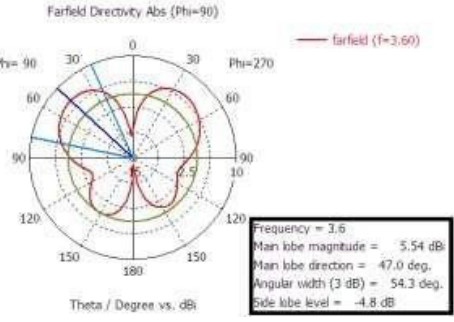
Figure 4.2: Farfield radiation pattern for 3.60GHz. The radiation pattern shown in figure 4.2 at 3.6